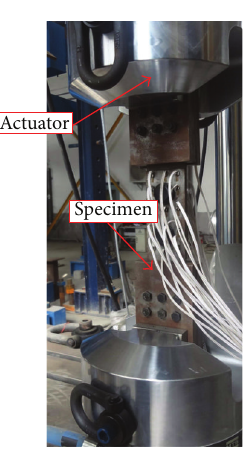
Figure 2: Experimental setup of the fretting fatigue test.